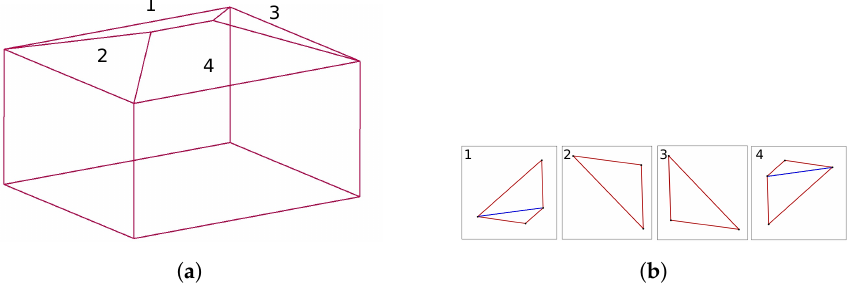
Figure 3. An example of CityGML building model representation and triangulation of its roof surfaces. ( a ) CityGML building model representation; ( b ) roof surface triangulation.